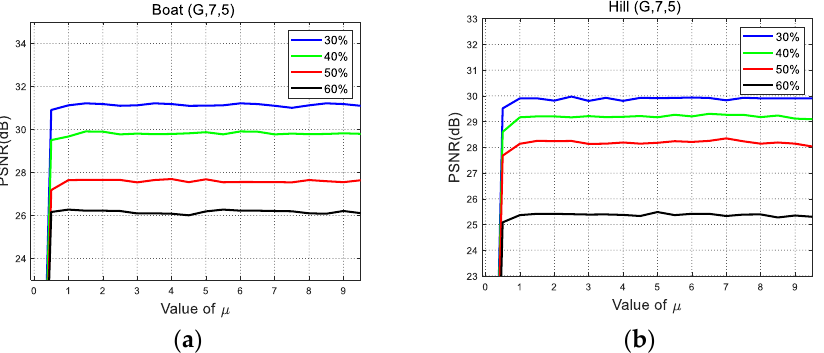
Figure 4. Effect of the regularization parameter  on the experimental results. ( a ) Effect of  on Figure 4. E ff ect of the regularization parameter µ on the experimental results. ( a ) E ff ect of µ on peak